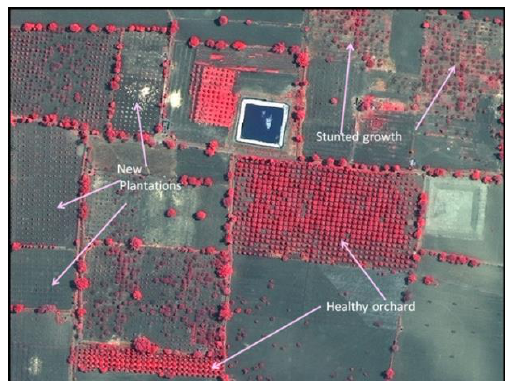
Figure 3. Methodology for Object-based classification and